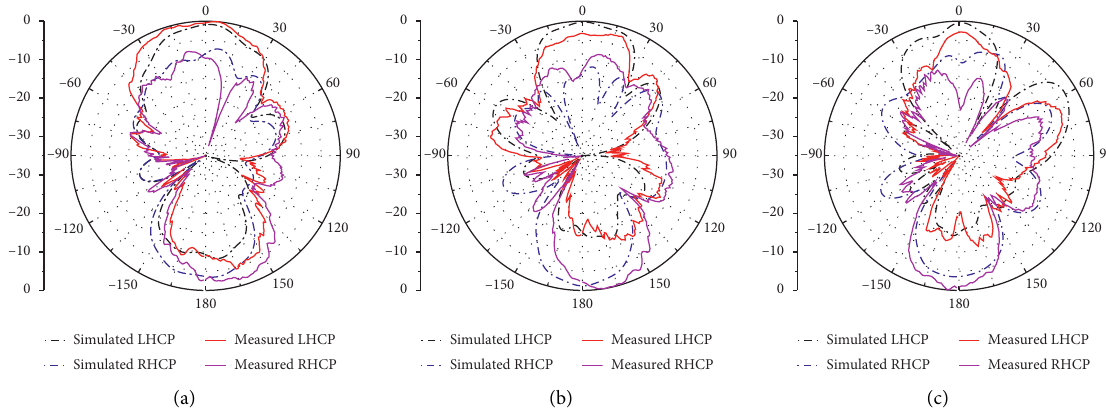
Figure 13: Measured and simulated radiation patterns of the proposed array in the yoz plane: (a) radiation patterns at 25GHz, (b) radiation patterns at 28GHz, and (c) radiation patterns at 31GHz. Table 3: Comparisons to reported 2 × 2mmWave wideband CP antenna arrays.